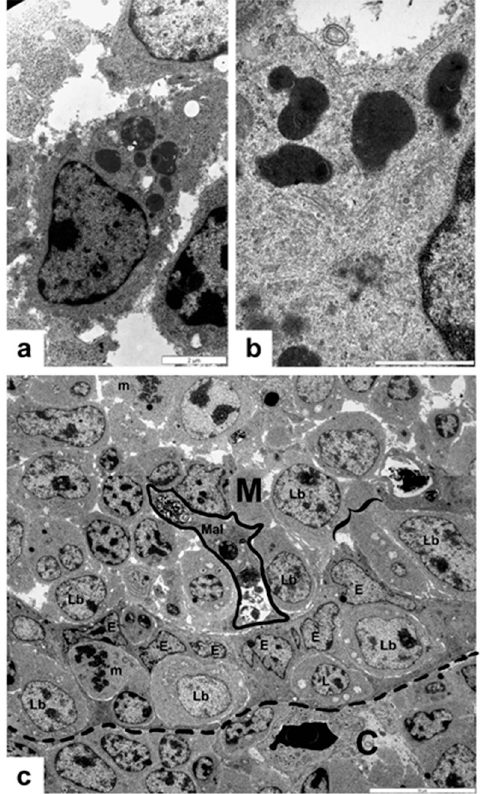
Figure 1. Transmission electron microscopy showing the BSDC and cortico-medullary (CM) border. ( a ) Mature BSDCs. The eccentrically located nucleus and the electron-dense granules collect in one of the cell processes endowed with polarity of the BSDCs. The substance of discharged granules attaches to the BSDC membrane. ( b ) The irregular-shaped, fused cytoplasmic granules are around the Golgi zone and centriole (C). ( c ) In the cortico-medullary epithelial arches (CMEA), lymphoblasts (Lb), medium-sized lymphocyte-like cells (L), and mitotic figures (m) are found. The clamp shows the opening of a CMEA and two lymphoid-like cells enter the medulla Basal lamina: dashed line; E: cell of CMEA; M: medullary; C: cortex; m: mitosis; Mal: macrophage-like cell (with apoptotic lymphocytes outlined) .